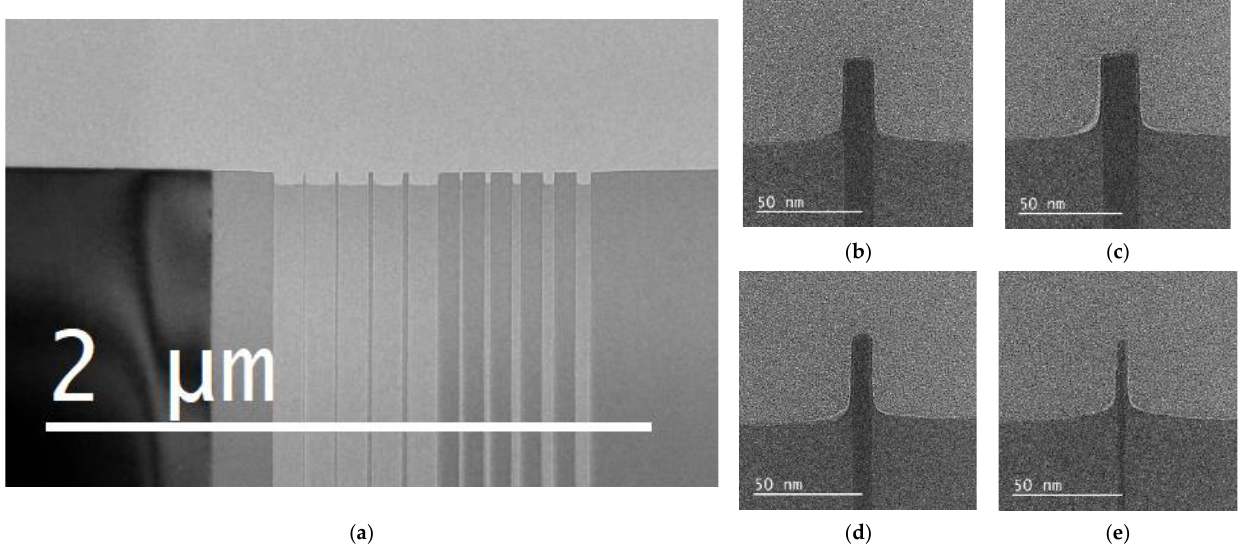
Figure 5. TEM image of multi-structured tip characterizer: ( a ) The whole profile of protruding parts and grooves; ( b ) 20 nm protruding CD structure; ( c ) 15 nm protruding CD structure; ( d ) 10 nm protruding CD structure; ( e ) 5 nm protruding CD structure.